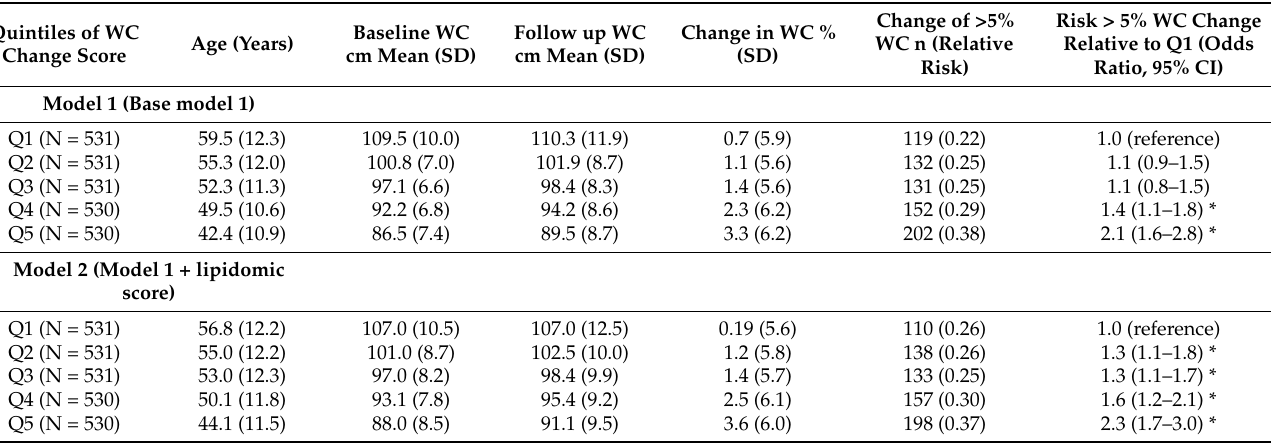
Table 2. Multivariate models predicting gain in WC in men.